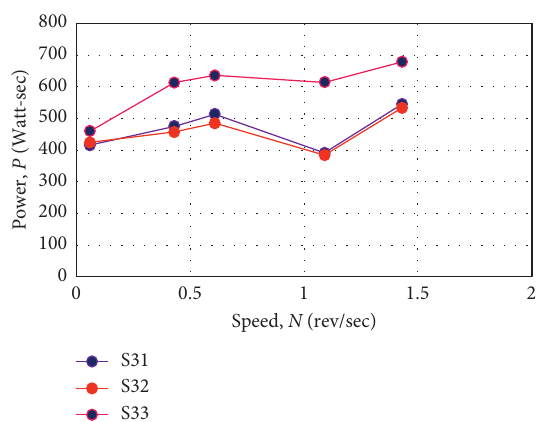
Figure 10: Power consumption for M40 grade concrete.